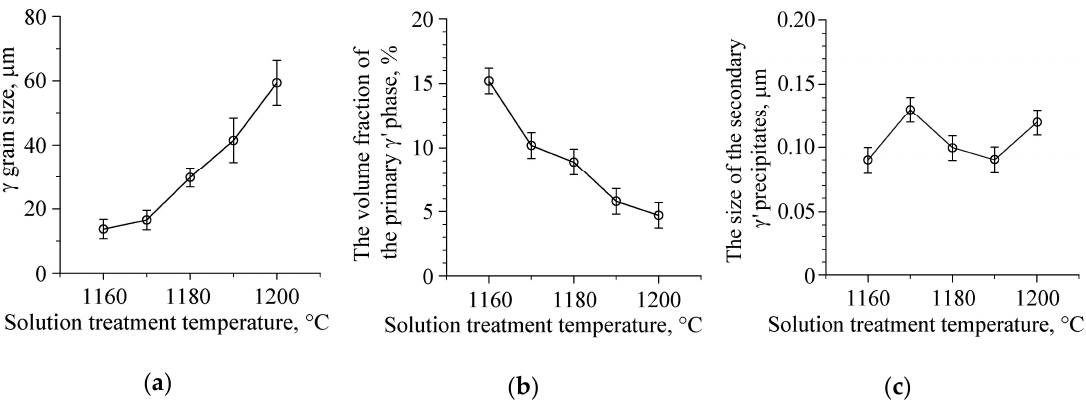
Figure 4. The dependencies of ( a ) the γ grain size, ( b ) the volume fraction of the primary γ ′ phase and ( c ) the size of the secondary γ ′ precipitates obtained after solid solution treatment at different temperatures followed by ageing.